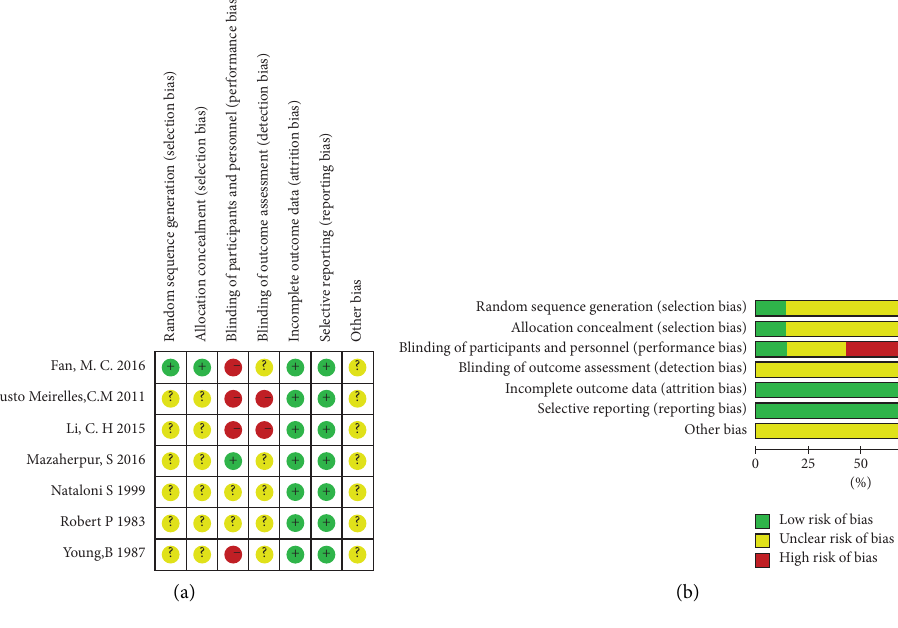
Figure 2: Quality assessment of included